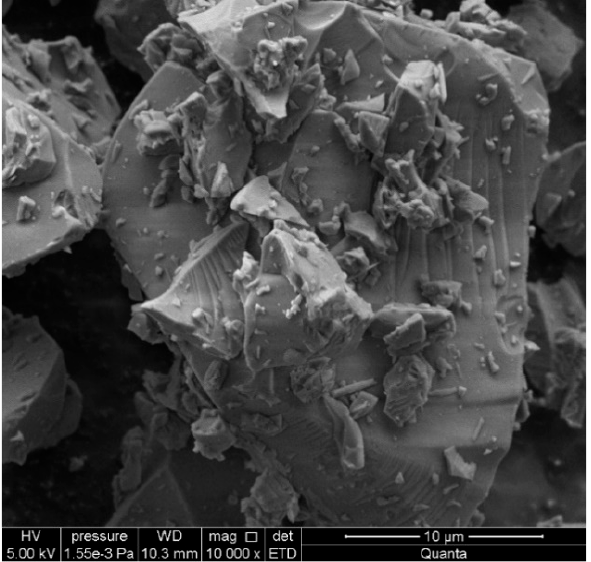
Figure 1. Microstructure of packaging glass.